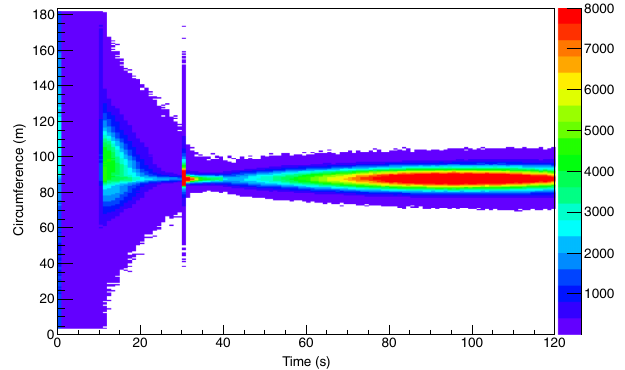
FIG. 4. The longitudinal distribution of polarimeter events for one machine cycle shown as a function of the circumference of the ring and as a function of the time during the store. The sequence of features is described in the text. A lower cutoff has been imposed on this picture at the level of 5 events = bin; below this level no events are shown. Backgrounds in the vacant regions of this figure were typically 0.1 – 0.2 events = bin, which is approximately 10 − 4 of the average rate in the colored region of the